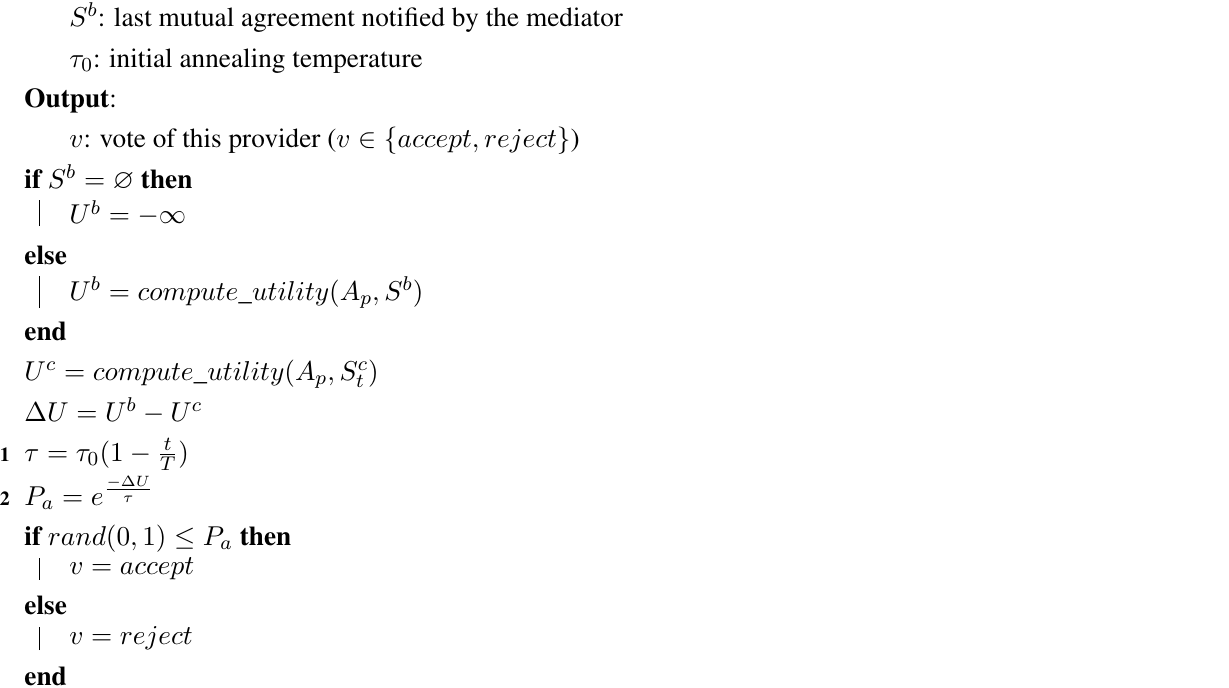
Algorithm 3: Annealer voting